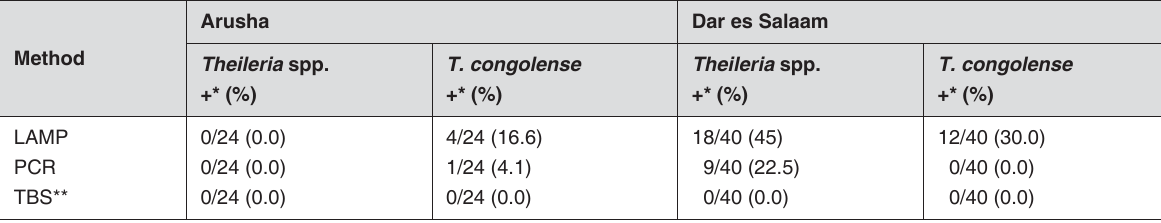
TABLE 1 Detection performance of LAMP, PCR and thin blood smears